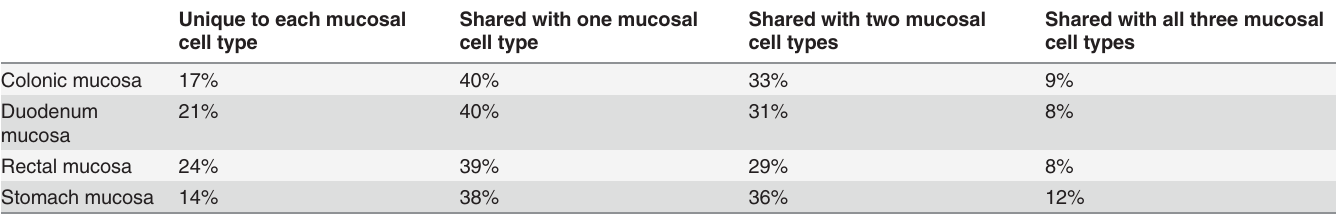
Table 2. Similarity of H3K4me3 segments between different mucosal cell